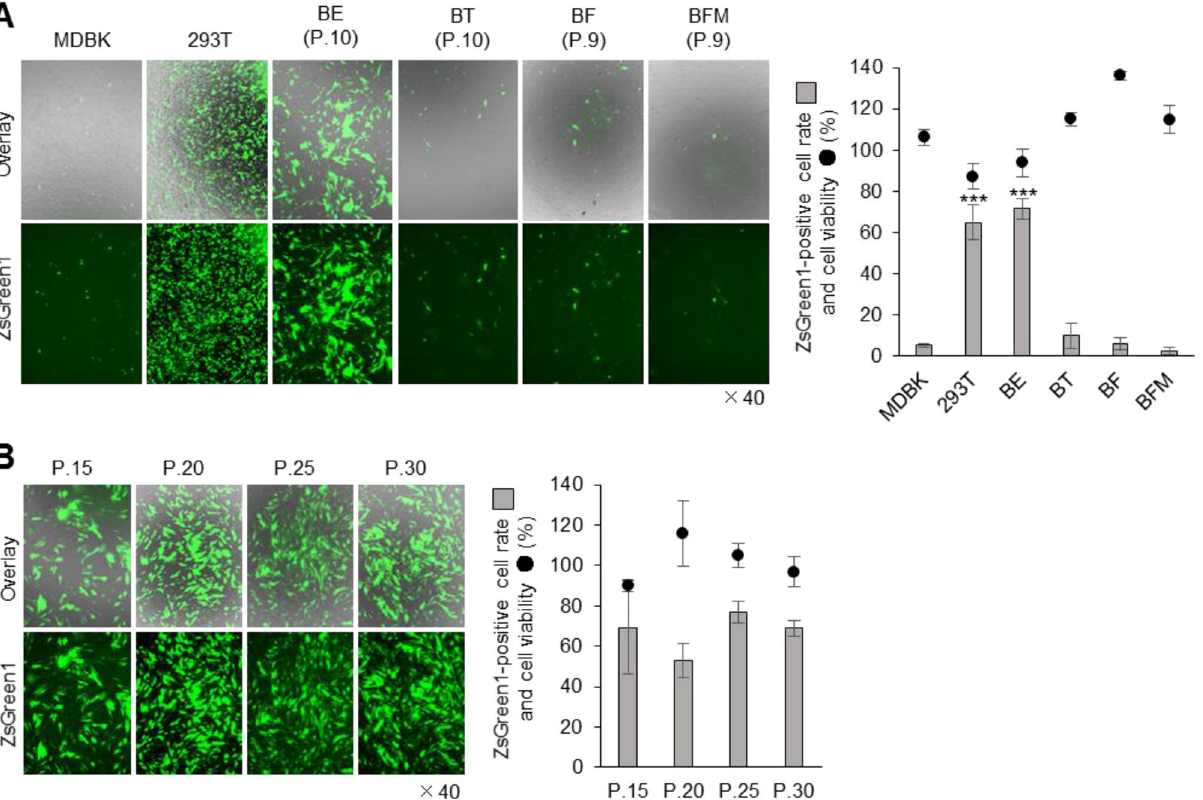
Figure 1. Transfection efficiency of lipofection in bovine-derived cultured cells. ( A ) MDBK, 293T, BE, BT, BF and BFM cells were seeded on a 24-well culture plate and transfected with 250 ng/well of ZsGreen1- expression vector, using the TransFectin Lipid Reagent. The transfected cells were observed under a fluorescence microscope at 48 h post transfection (hpt; left pictures). The ZsGreen1-positive cell rate and cell viability were measured at 48 hpt (right graph). Asterisks indicate significant differences from the control MDBK cells (*** P < 0.001). ( B ) One BE cell clone could be passaged 30 times and maintained high lipofection efficiency. The transfection assay was described for ( A